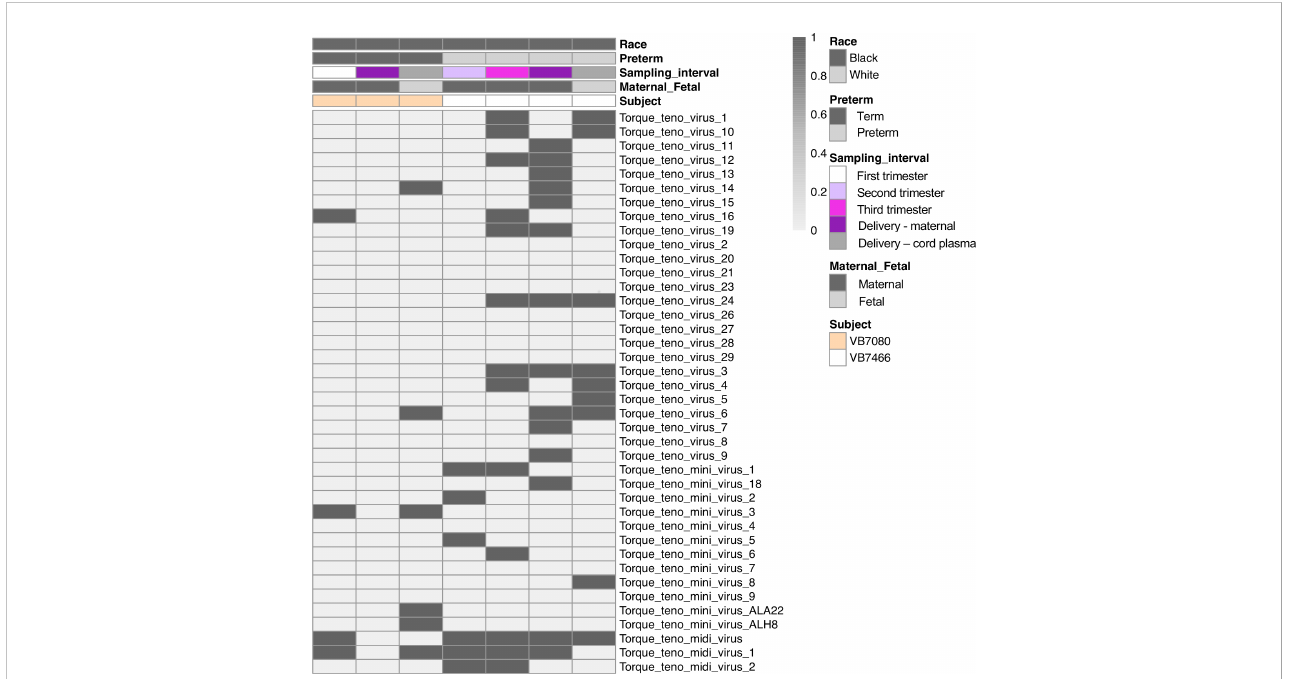
FIGURE 3 Anellovirus distribution in the two anellovirus-positive cord plasma samples and the corresponding maternal samples. Each column shows data from an individual sample from a subject. The top 5 rows indicate how samples are grouped based on race, preterm status, sampling interval (e.g. trimester of sampling or delivery), maternal or fetal sample, and subject. Each of the remaining rows represents data from an individual virus. A dark bar indicates the virus was detected in that